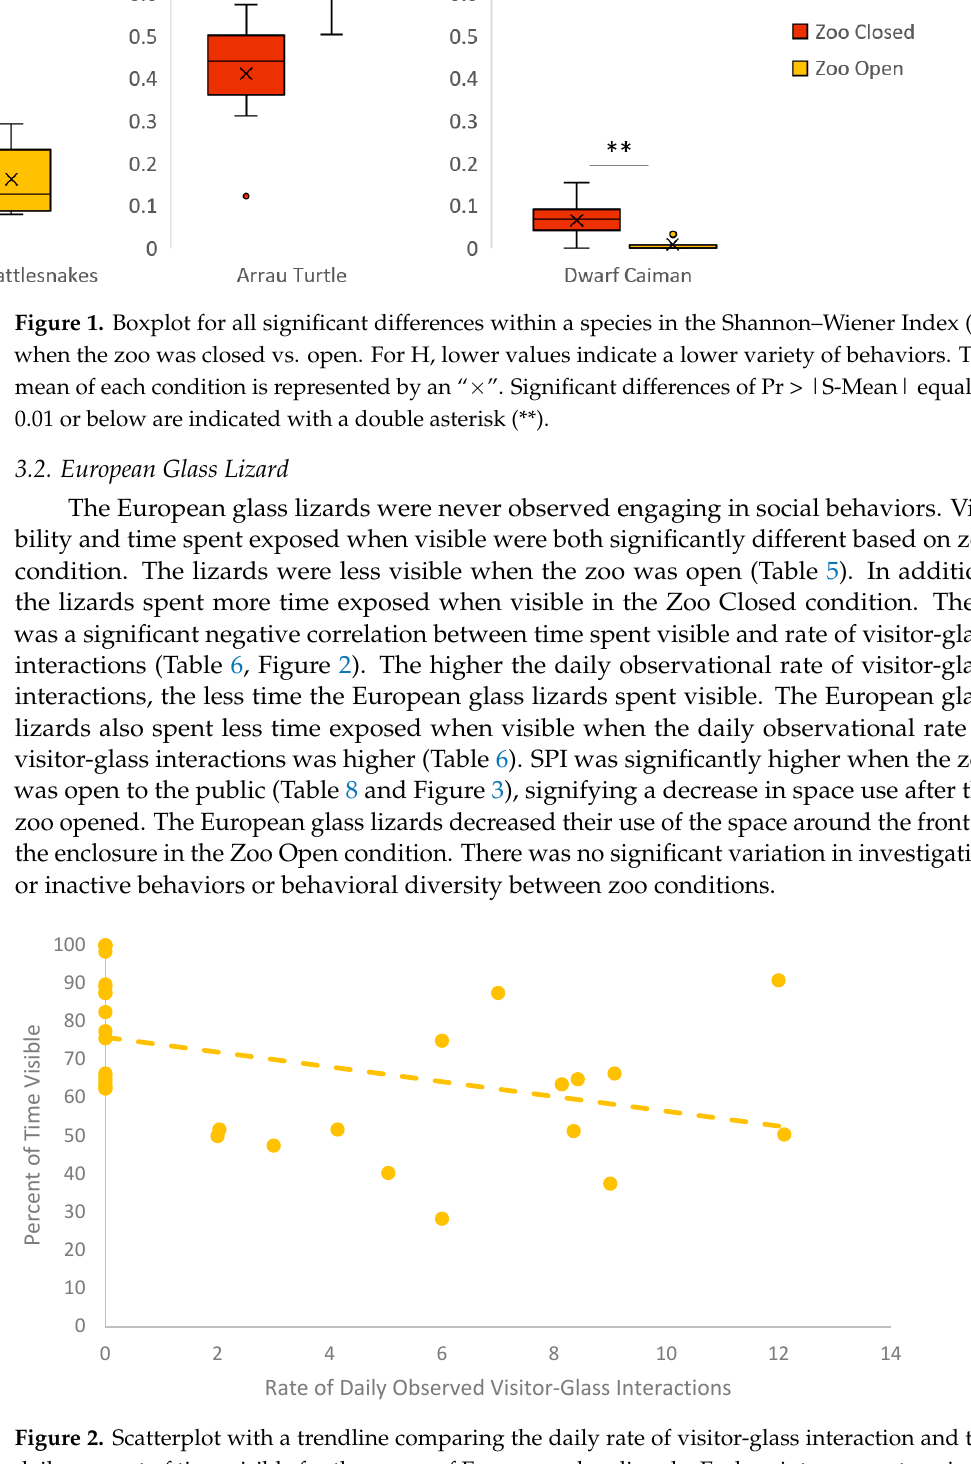
Figure 3. Boxplot for all significant differences within a species in the Dickens’ Spread of Participa- tion Index (SPI) when the zoo was closed vs. open. For SPI, lower values mean more even space use. The mean of each condition is represented by an “×” and all outliers are indicated by circles. Signif- icant differences (Pr > |S-Mean| below 0.05) are indicated with an asterisk (*), and Pr > |S-Mean| of 0.01 or below are indicated with a double asterisk (**). 3.3. Beaded Lizard The beaded lizards spent less time engaged in social behaviors when the zoo was closed as opposed to when the zoo was open (Table 5). The majority of the social behavior consisted of breeding-related behaviors, such as mounting. The beaded lizards displayed no significant variations in investigative behaviors, inactivity, visibility, time spent ex- posed when visible, behavioral diversity, or evenness of space use between zoo condi- tions. There was also no significant correlation between visitor-glass interactions and vis- ibility. 3.4. Sonoran Spiny-Tailed Iguana The Sonoran spiny-tailed iguana’s social behavior was infrequent and never rec- orded during an interval scan. Time spent exposed when visible was significantly higher